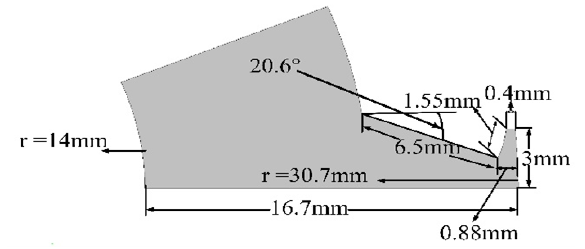
Figure 24. Hybrid (arc and flange) of the rotor